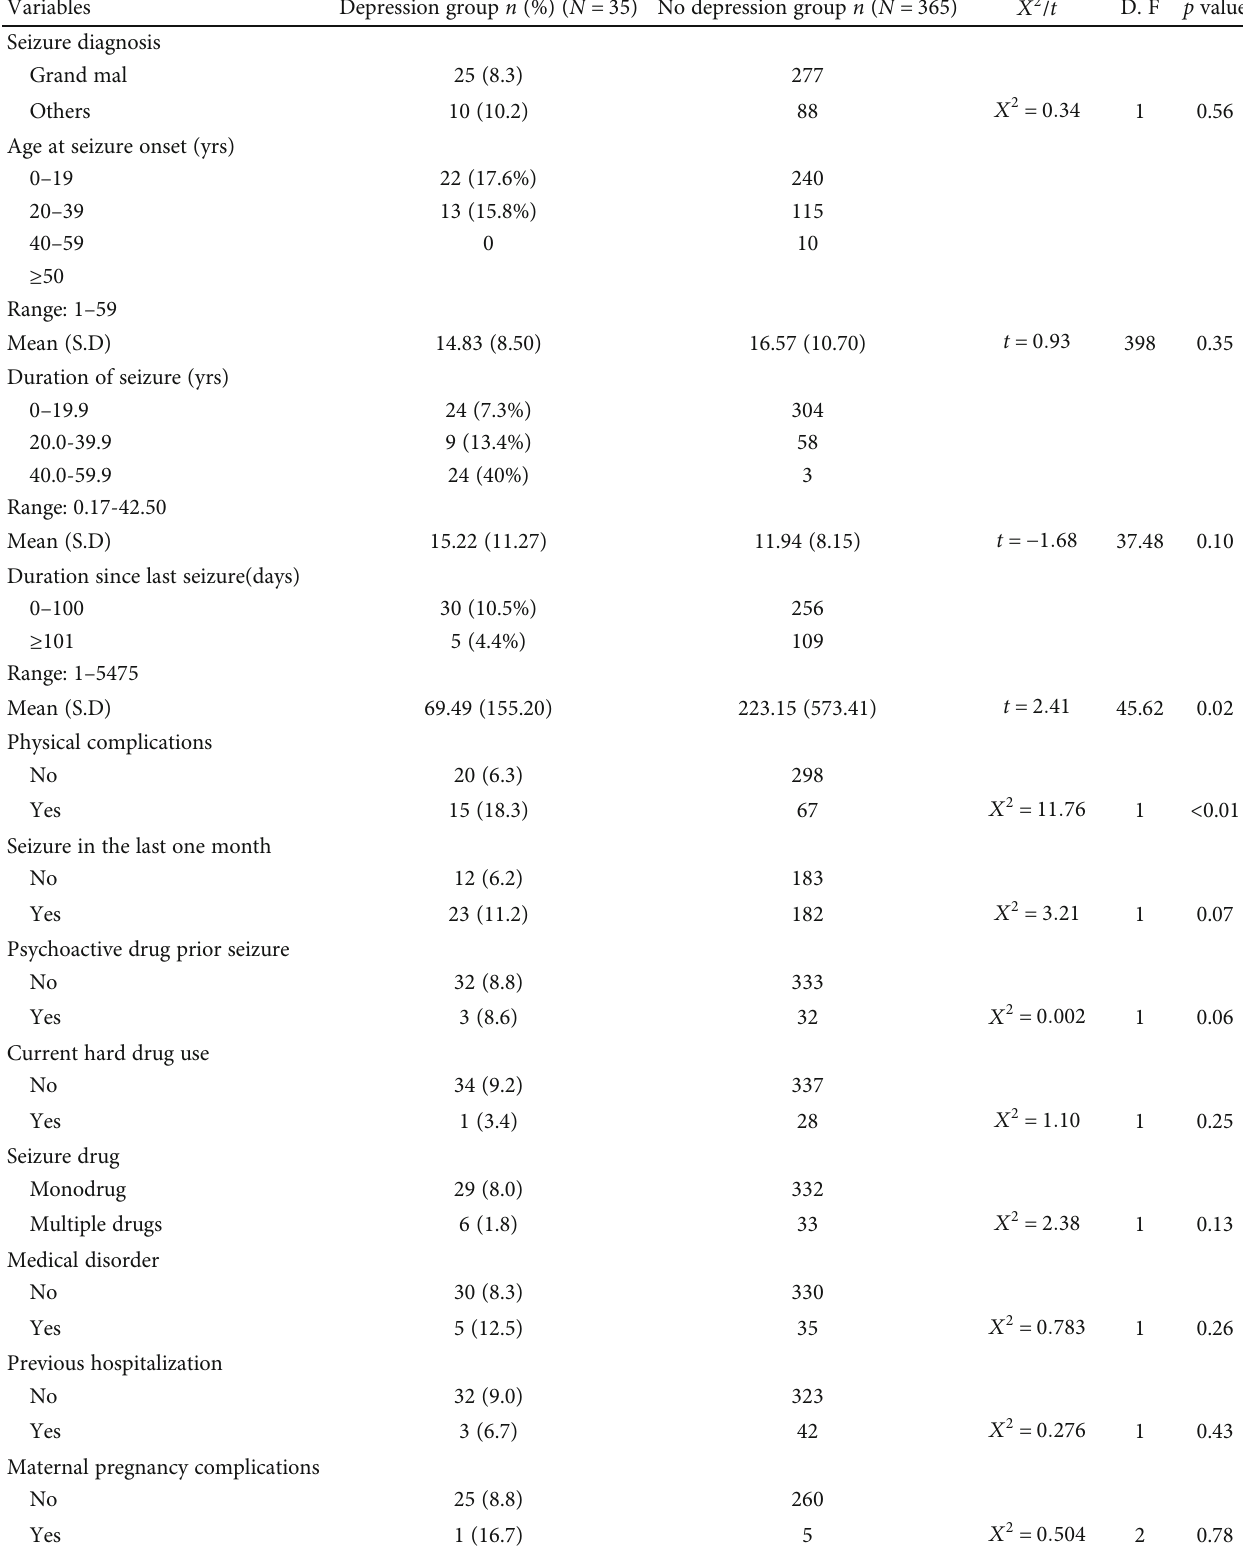
Table 3: Comparison of the clinical characteristics of the study subjects in the depressed and nondepressed study groups ( n = 400 ).